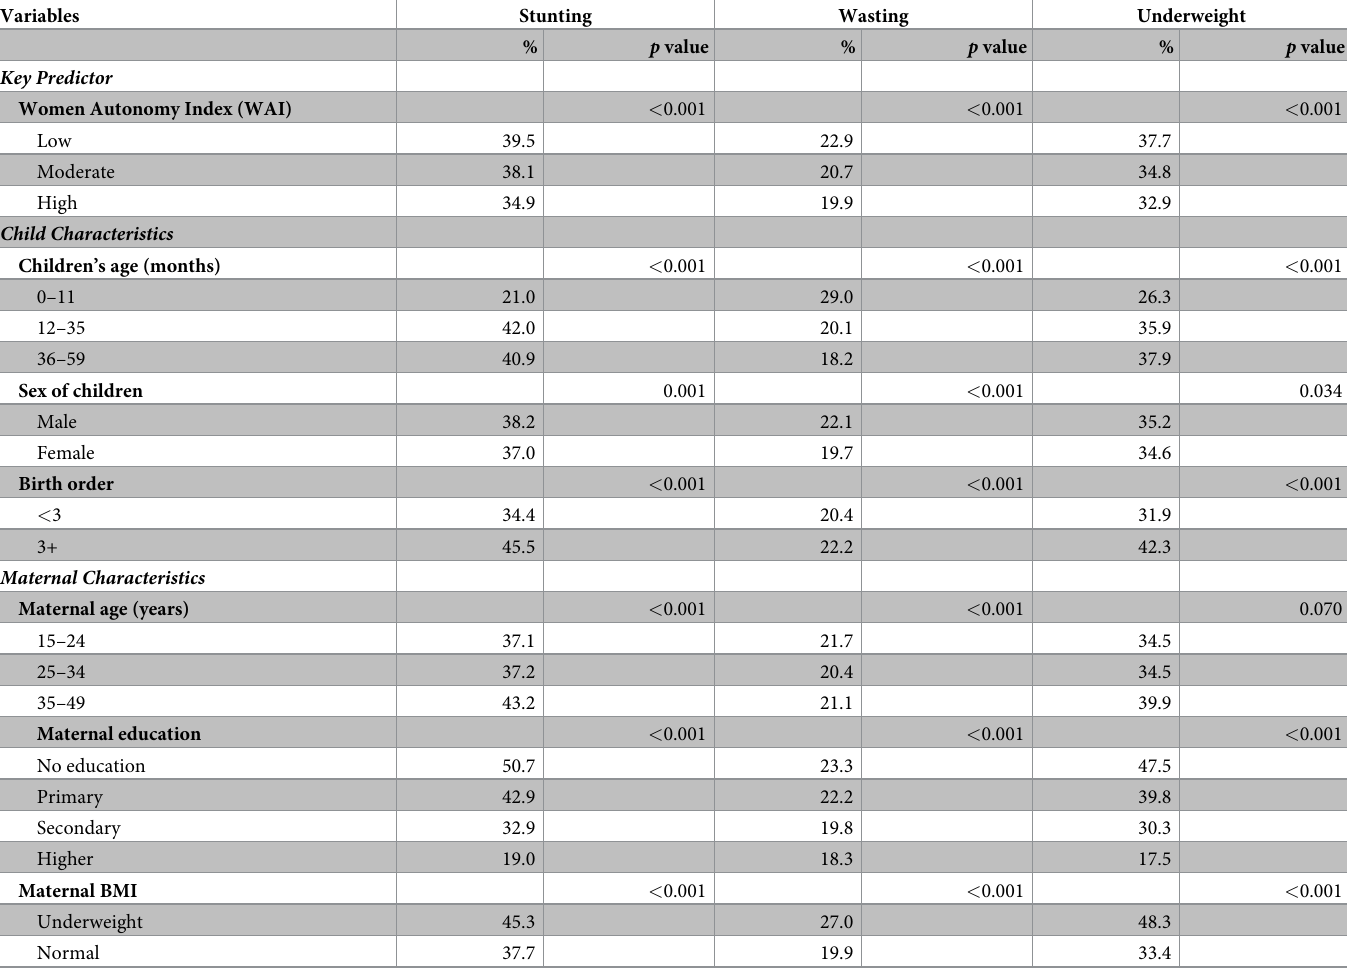
Table 2. Prevalence of stunting, wasting, and underweight among under-five children by selected explanatory variables, NFHS-4 (2015–16). Variables Stunting Wasting Underweight % p